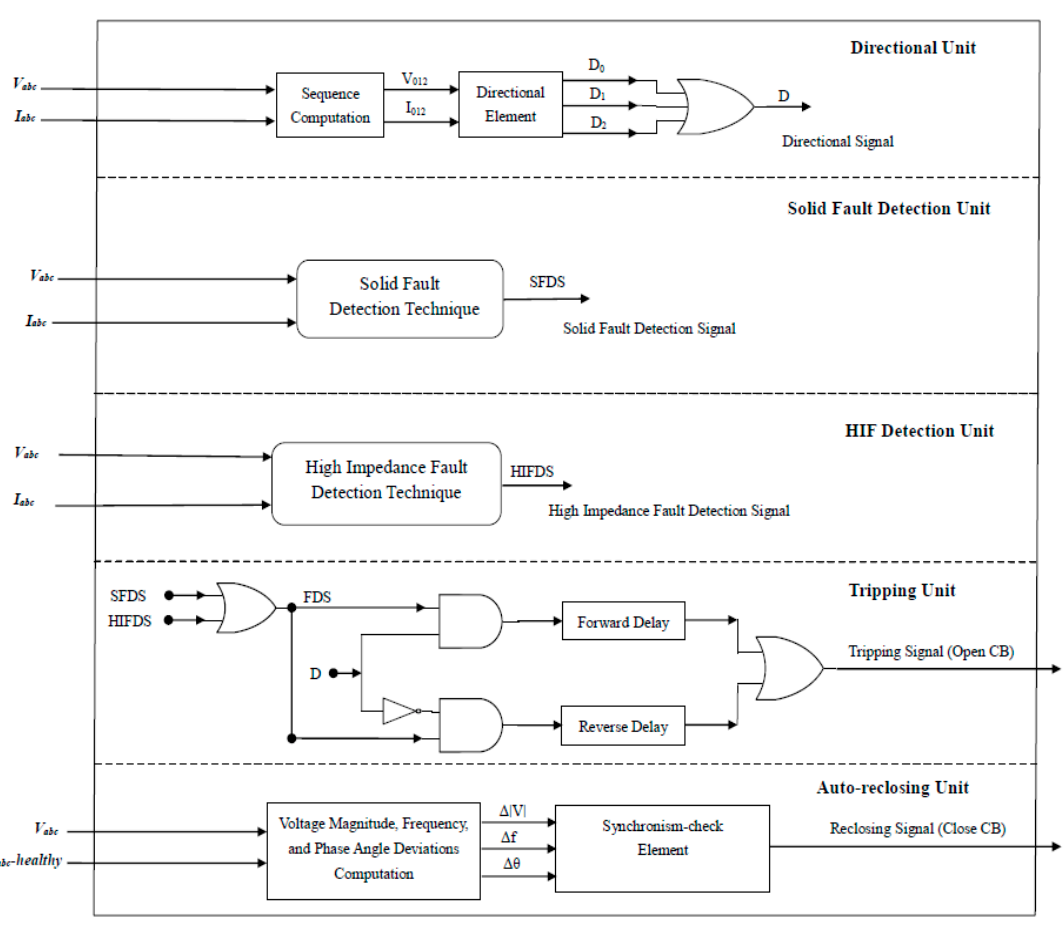
Figure 1. Schematic diagram of the communication-aided active distribution network (ADN) protection digital relay (CAPDR) and its operational units.